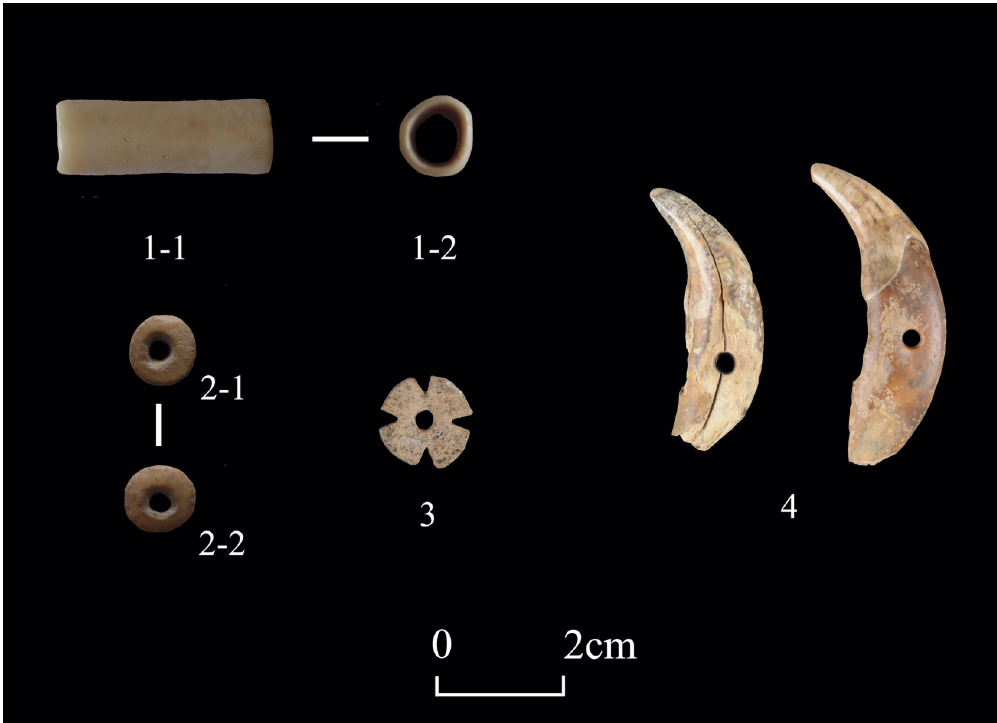
Fig 5. Examples of ornaments from Shirenzigou. 1) specimen from 12XBSIIIT0721I-3 ④ ; 2) specimen from 12XBSIIIT0721II-2JX6 ② ; 3) specimen from 2010HBS Ⅲ T0619 Ⅲ② ; 4) specimen from 2007BSDM016.